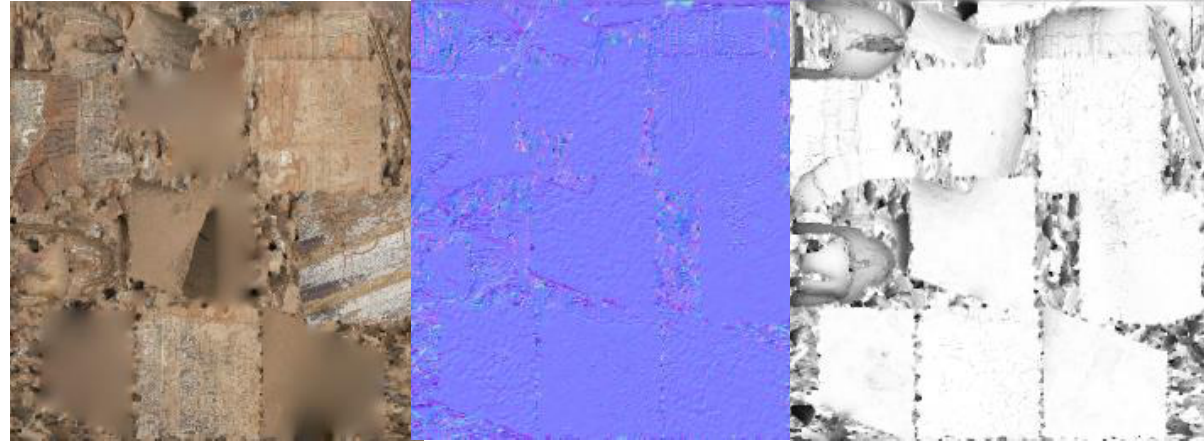
Figure 5. Mesh maps from the Myin-pya-gu model: a texture map (left), normal map (middle), and ambient occlusion map